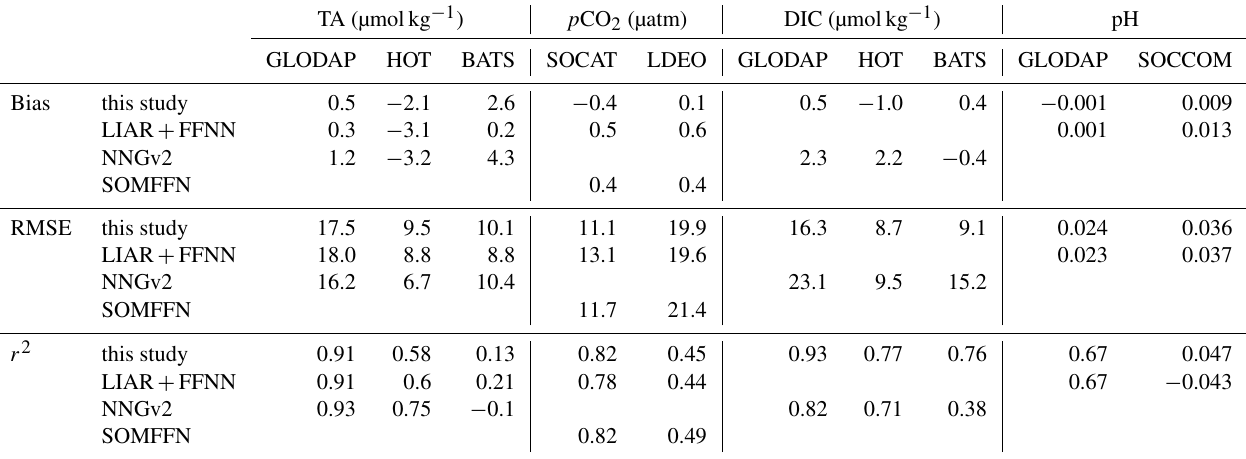
Table 4. Comparison of training and independent data sources with various methods for the open-ocean region using the COSCATs coastal mask by Laruelle et al. (2013). GLODAP refers to the GLODAP v2 2019 data (Olsen et al., 2019), HOT refers to the Hawaii Ocean Time- series (Dore et al., 2009), BATS refers to Bermuda Atlantic Time-series Study (Bates and Peters, 2007), SOCAT is the 2019 version of the Surface Ocean Carbon Atlas (Bakker et al., 2016), LDEO is the Lamont-Doherty Earth Observatory p CO 2 data set for points not present in SOCAT (Takahashi et al., 2020), and SOCCOM is the pH measured by autonomous floats from the Southern Ocean Carbon and Climate Observations and Modeling project (Johnson et al., 2016). Statistical outliers were excluded in the calculation of LDEO RMSE. OS-ETHZ is the OceanSODA-ETHZ data from this study, NNGv2 is from Broullón et al. (2018), LIARv2 from Carter et al. (2018), CMEMS-FFNNv2 from Denvil-Sommer et al. (2019), and SOMFFN from Landschützer et al. (2016). NNGv2 and LIARv2 predictions are made with SODA salinity and OSTIA sea-surface temperature, resulting in different estimates to the original publications (Broullón et al., 2018; Carter et al., 2018). Note that the full data set is used for OceanSODA-ETHZ, unlike Table 3, which presents the errors for test years. TA (µmolkg − 1 ) p CO 2